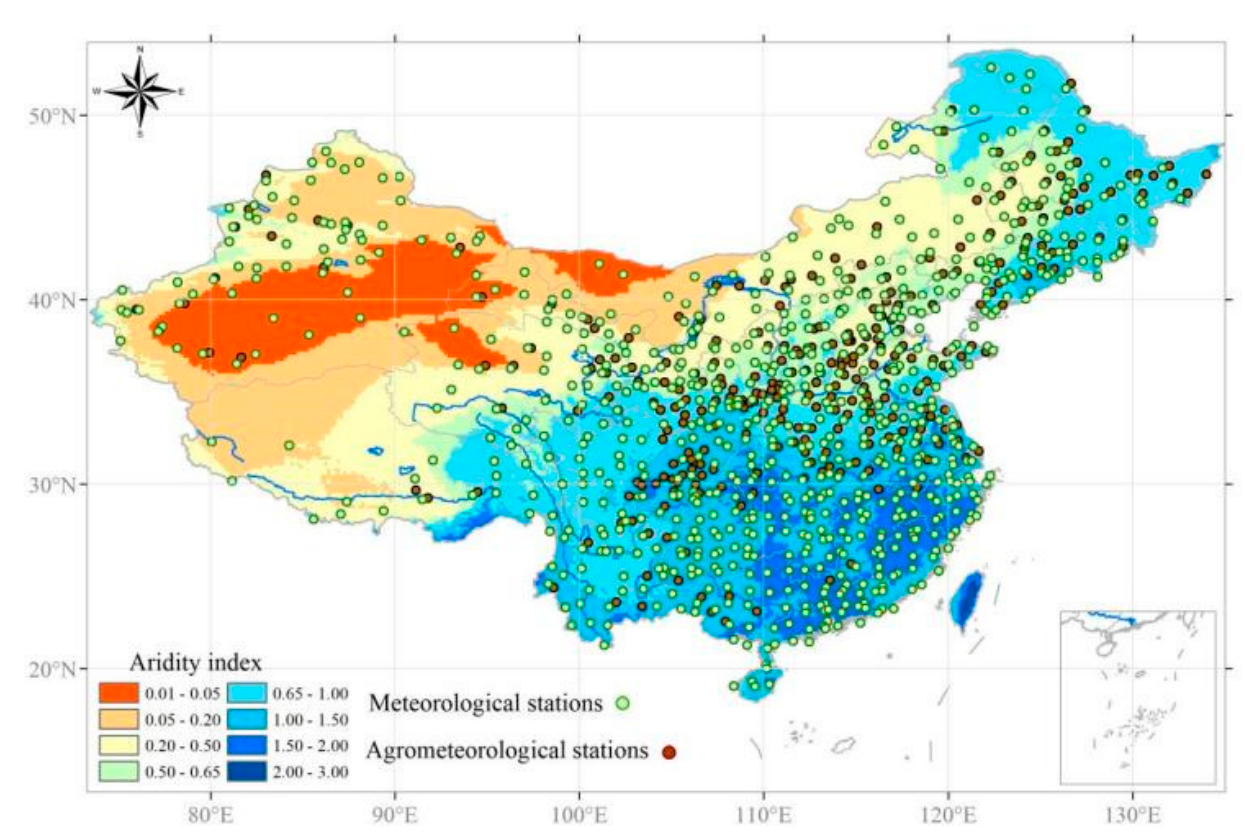
Figure 2. Spatial distribution of the national meteorological stations and Chinese agrometeorological stations and climate zones.